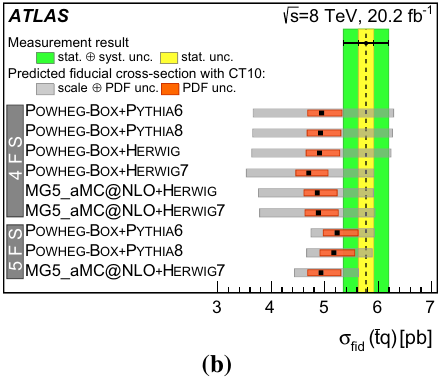
Fig. 9 Measured t -channel a single-top-quark and b single-top- antiquark fiducial cross-sections compared to predictions by the NLO MC generators Powheg - Box and MadGraph5 _aMC@NLO in the four-flavour scheme (4FS) and five-flavour scheme (5FS) combined